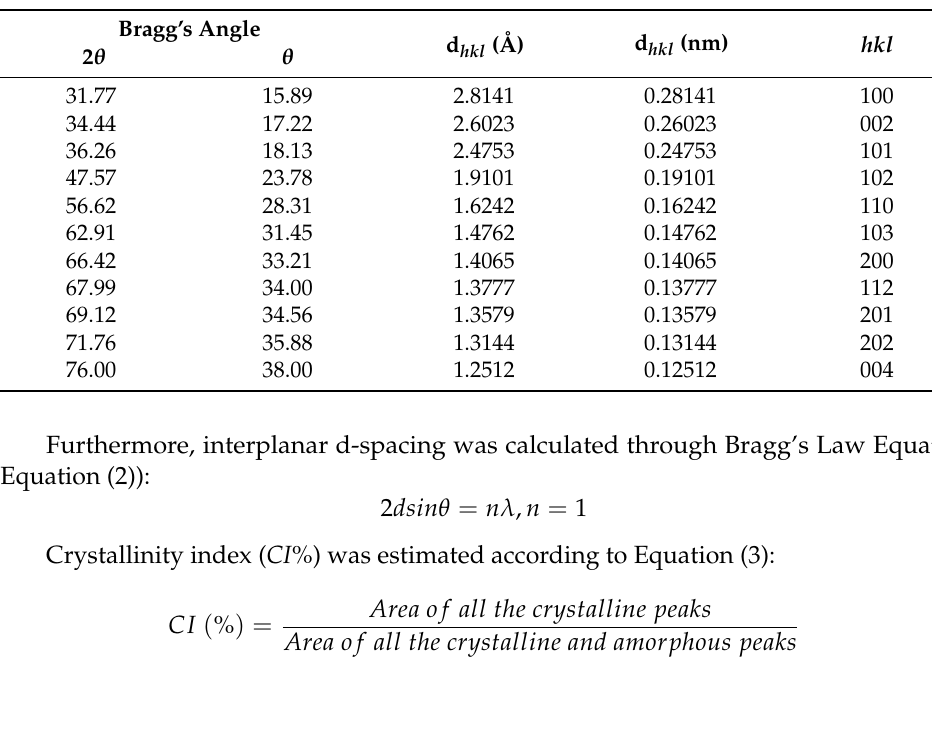
Table 5. d-spacing calculations for ZnSulf